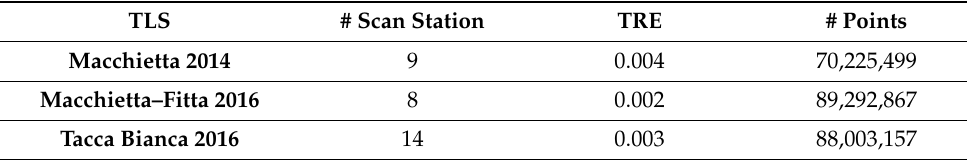
Table 5. Information related to the M-TLS post-processing